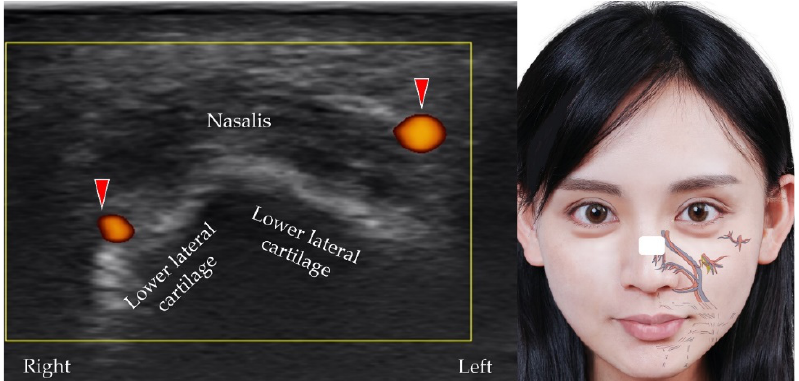
Figure 9. Power Doppler ultrasound imaging of the dorsal nasal artery ( red arrowheads ) and its branches. White square , footprint of the ultrasound transducer.